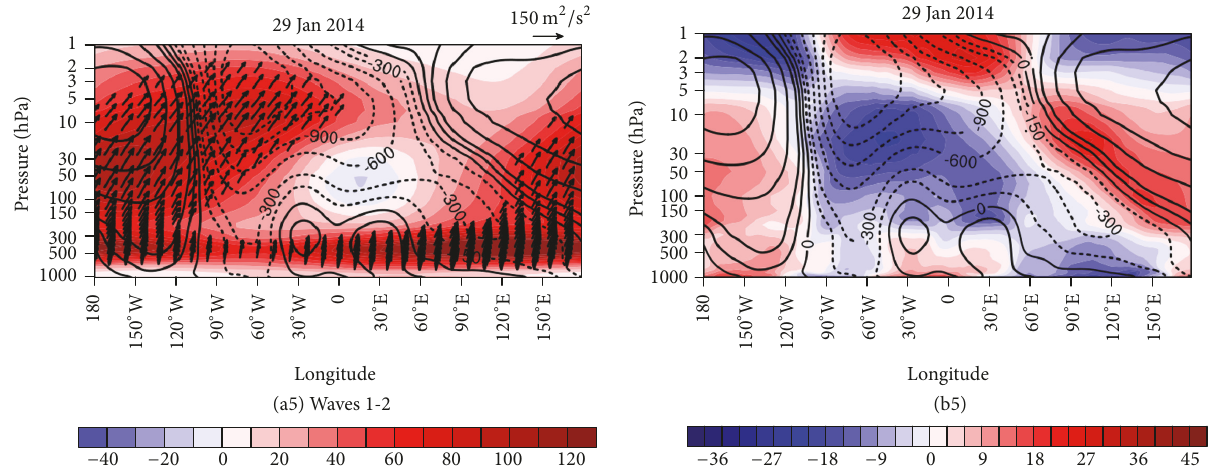
Figure5:Longitude-pressurecross-sectionsofthedaily50 ∘ –70 ∘ Nmeanzonalanomalyofgeopotentialheight(contours;gpm),WAF(vectors: > 60m 2 s −2 only), and WAFz (shading; m 2 s −2 ) of PWs 1 and 2 in January 2014 ((a1)–(a5)). ((b1)–(b5)) As in ((a1)–(a5)), respectively, but for the geopotential height anomaly (contours; m) and temperature (shading; K). WAF components are scaled by √1000 hPa /𝑝 horizontally and by 100 × √1000 hPa /𝑝